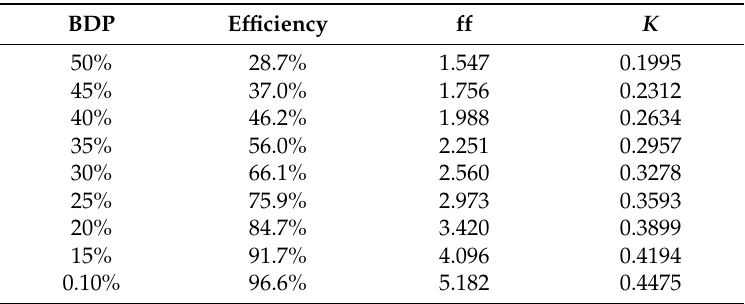
Table A1. Relation between Efficiency and Break Down Point